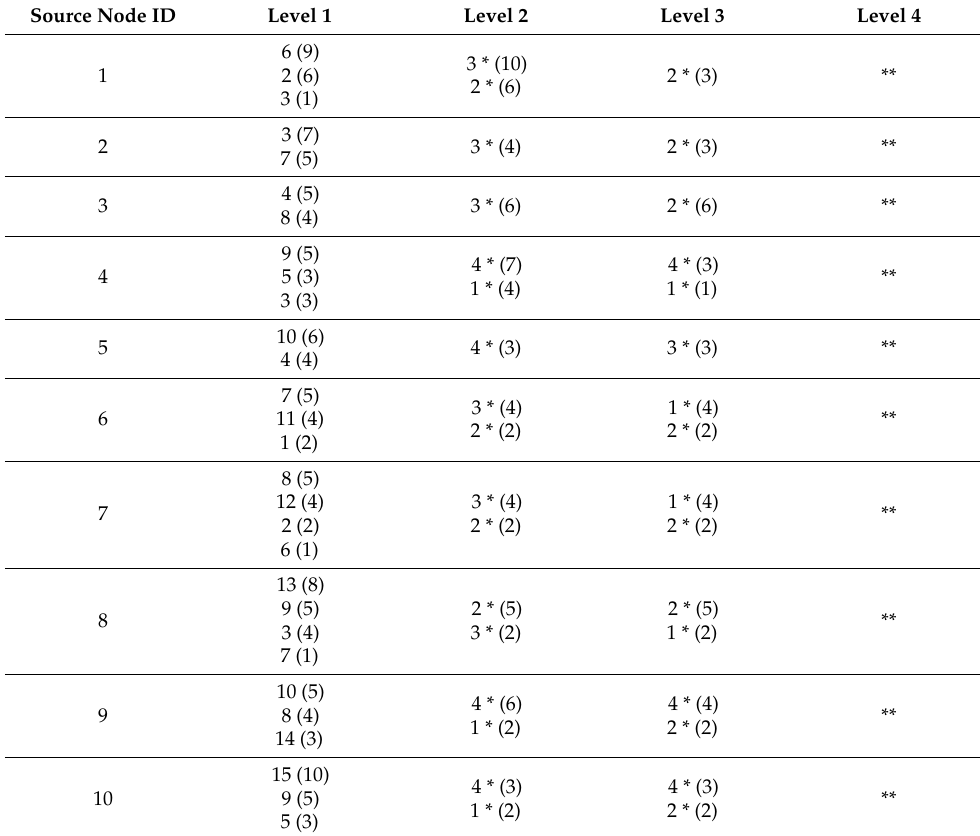
Table 4. The movement frequency